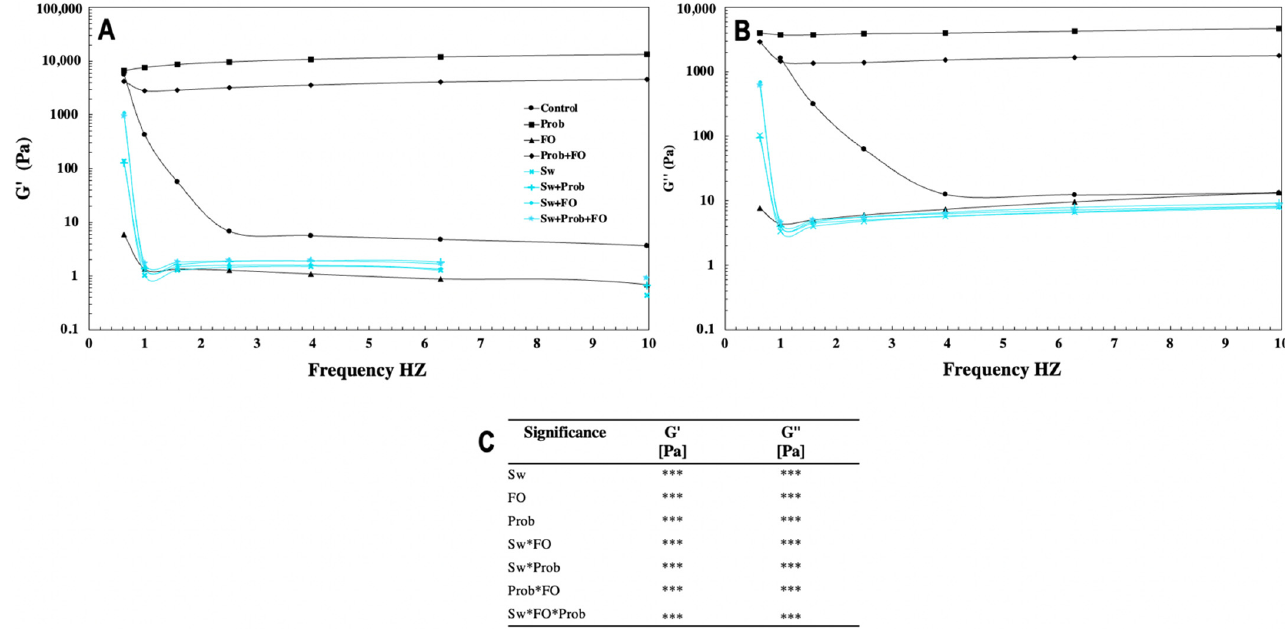
Figure 2. Frequency sweep test of chocolate at 35 °C with a linear viscoelastic region of 6 Pa. ( A ) Changes in storage modulus G’. ( B ) Changes in loss modulus G’’. ( C ) Full factorial analysis of variance showing the main effects and interactions of the variables evaluated. Values represent the mean of 3 replicates. Asterisks indicate significant difference from a full factorial analysis of variance showing the main effects and interactions of the variables evaluated: *** p < 0.001 . Treatments: Control = milk chocolate formulation, Prob = milk chocolate + probiotics, FO = milk chocolate + fish oil, Prob + FO = milk chocolate + probiotics + fish oil, Sw = isomalt + stevia, Sw + Prob = isomalt + stevia + probiotics, Sw + FO = isomalt + stevia + fish oil, Sw + Prob + FO = isomalt + stevia + probiotics + fish oil.